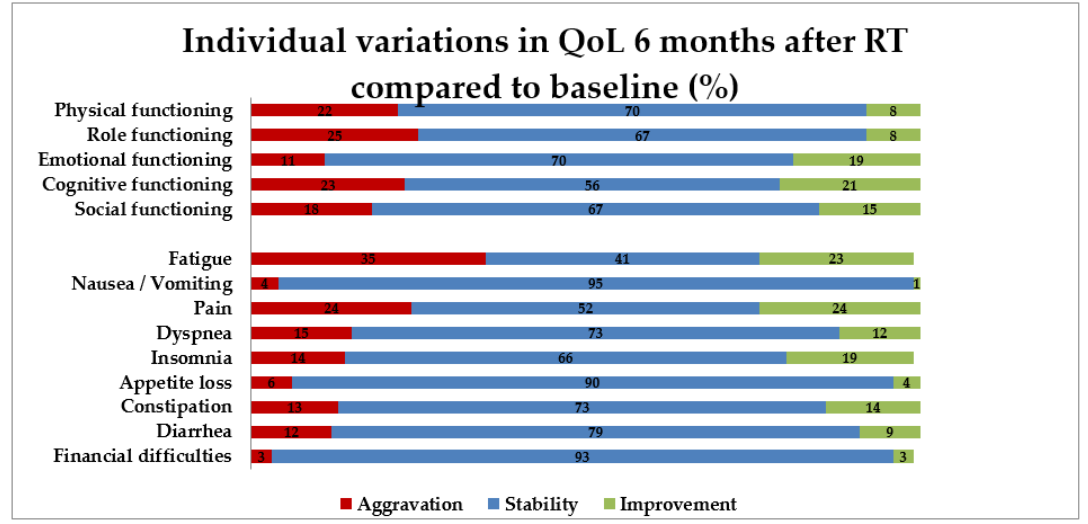
Figure 1. Individual variations in quality of life six months after radiotherapy compared to baseline. QoL: quality of life; RT: